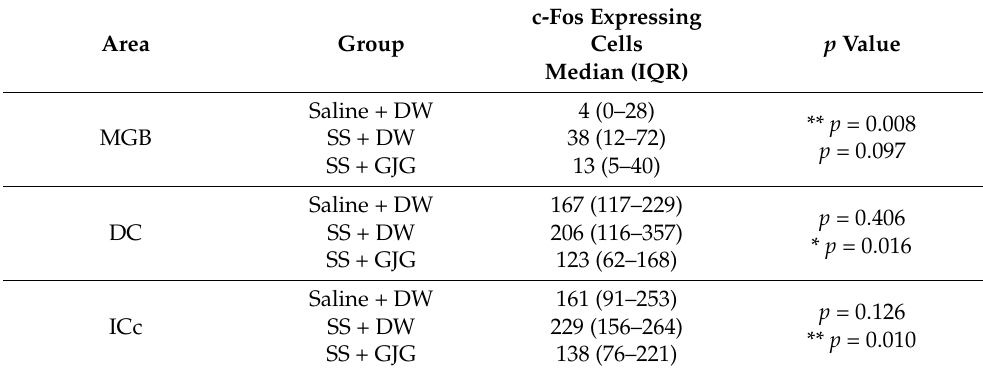
Table 3. Effect of goshajinkigan (GJG) administration on c-Fos expression in the auditory thalamus and brainstem nuclei of salicylate-treated